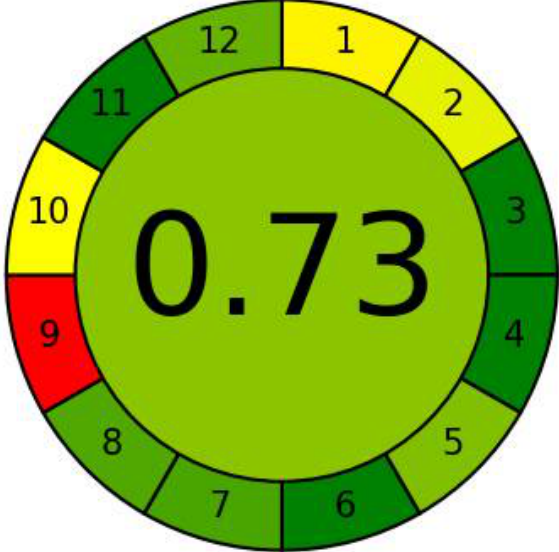
Figure 6. An AGREE Pictogram for Evaluation of the Proposed Method’s Greenness. Table 6. The Penalty Points of the Method for the Determination and Quantitation of the Tamatinib in Plasma.